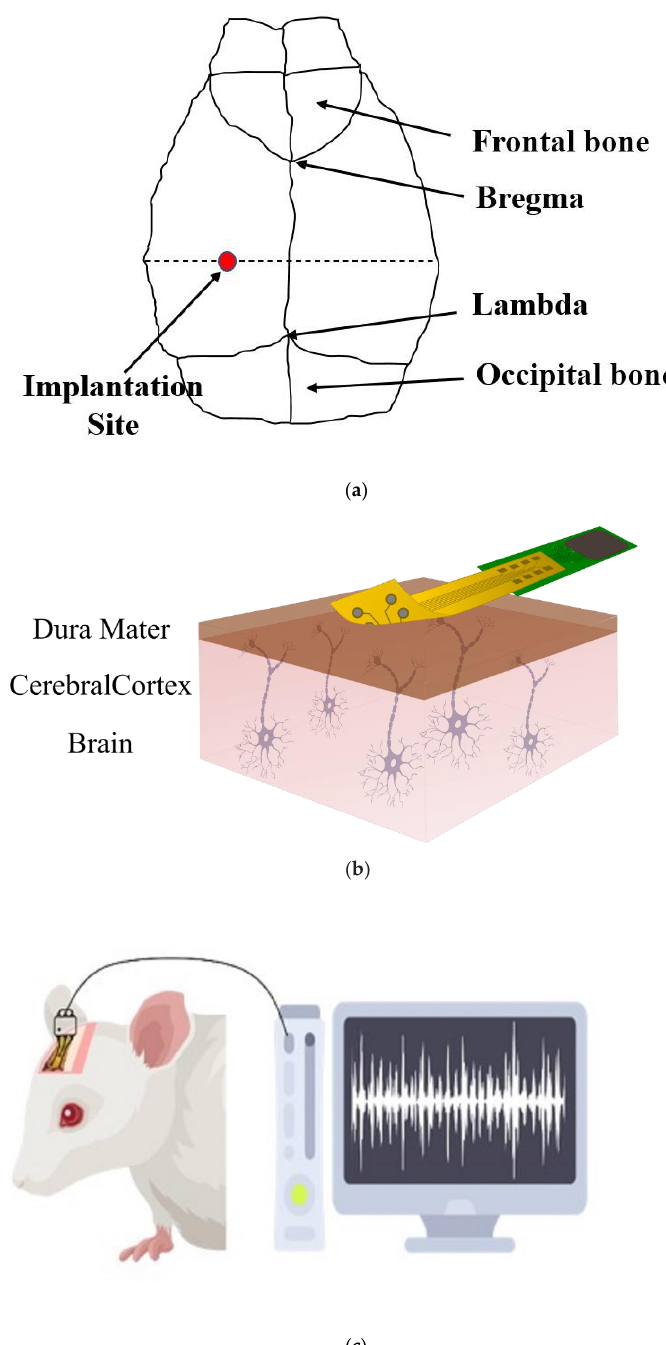
Figure 4. ( a ) Schematic diagram of the implantation site; ( b ) ECoG electrode implantation on the dura mater for neural recording; and ( c ) schematic of the experimental setup for ECoG signal